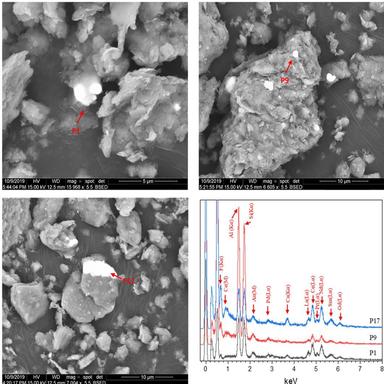
A rare earth carbonate particle found in SP25-F1 (Au and Pd were introduced during the coating process prior to the SEM-EDX analysis).